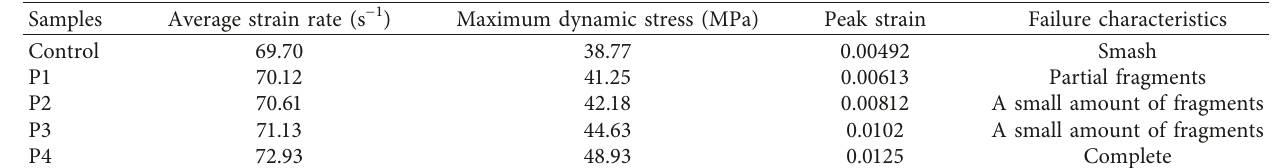
Table 5: The results of impact experiment.